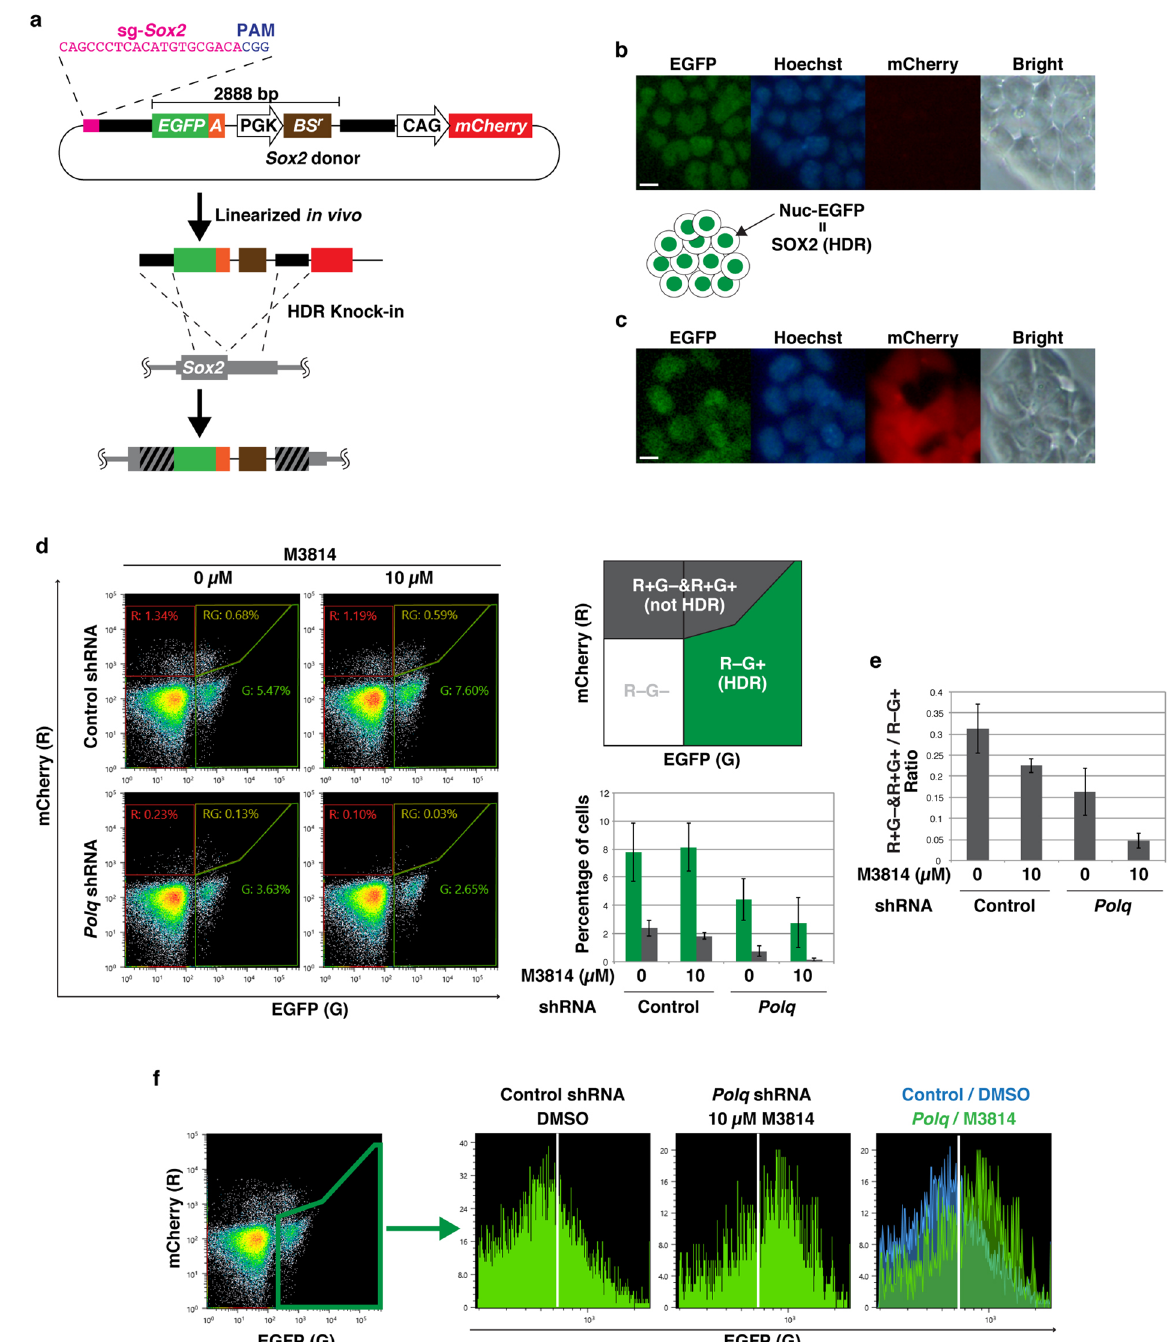
Figure 4. Tagging the endogenous Sox2 gene with Polq knockdown and M3814 treatment. ( a ) Schematic illustration of the Sox2 donor and the manner of HDR-mediated integration. Wide black bars and wide gray bars indicate the homology arms in the donor and the homologous region in the genome, respectively. Black- and-gray striped bars denote the homologous region undergoing HDR. ( b , c ) Images of living cells expressing only EGFP (R−G+) ( b ) and both mCherry and EGFP (R+G+) ( c ) observed by fluorescence microscopy. Nuclei were stained with Hoechst 33,342. Scale bar, 10 µm. ( d ) Flow cytometry analysis of mESCs transfected with the shRNA, Sox2 donor, and Cas9/sgRNA expression vector. The cells were treated with DMSO or M3814 as illustrated in Fig. 2a. A series of experiments, from transfection to flow cytometric analysis, was independently performed in triplicate. Scatter plots show representative results from the three experiments. The average ± standard deviation percentages of R−G+ (green) and R+G+ & R−G+ (gray) cells are shown in the bar graph. ( e ) The ratio of R+G+ & R−G+ vs R−G+ is shown in the bar graph. ( f ) Fluorescence intensity of EGFP expressed by R−G+ cells. Representative histograms from three independent experiments are